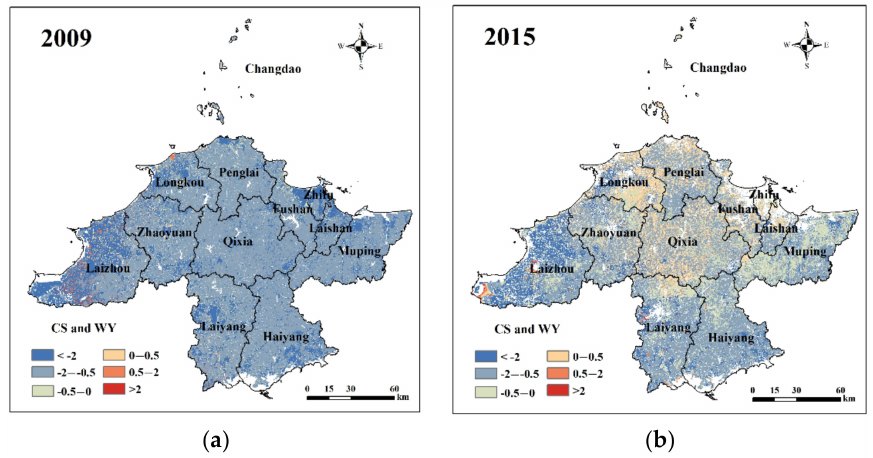
Figure 7. ( a ) Spatial synergies between carbon sequestration and water yield services in 2009; ( b ) spatial synergies between carbon sequestration and water yield services in 2015.